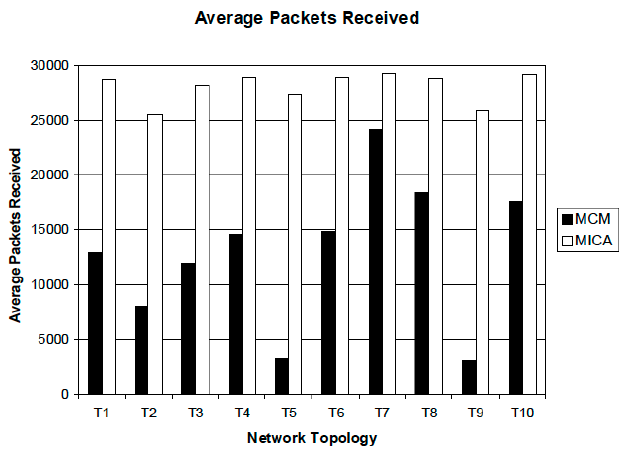
Figure 4. Average packets received by multi-receivers.